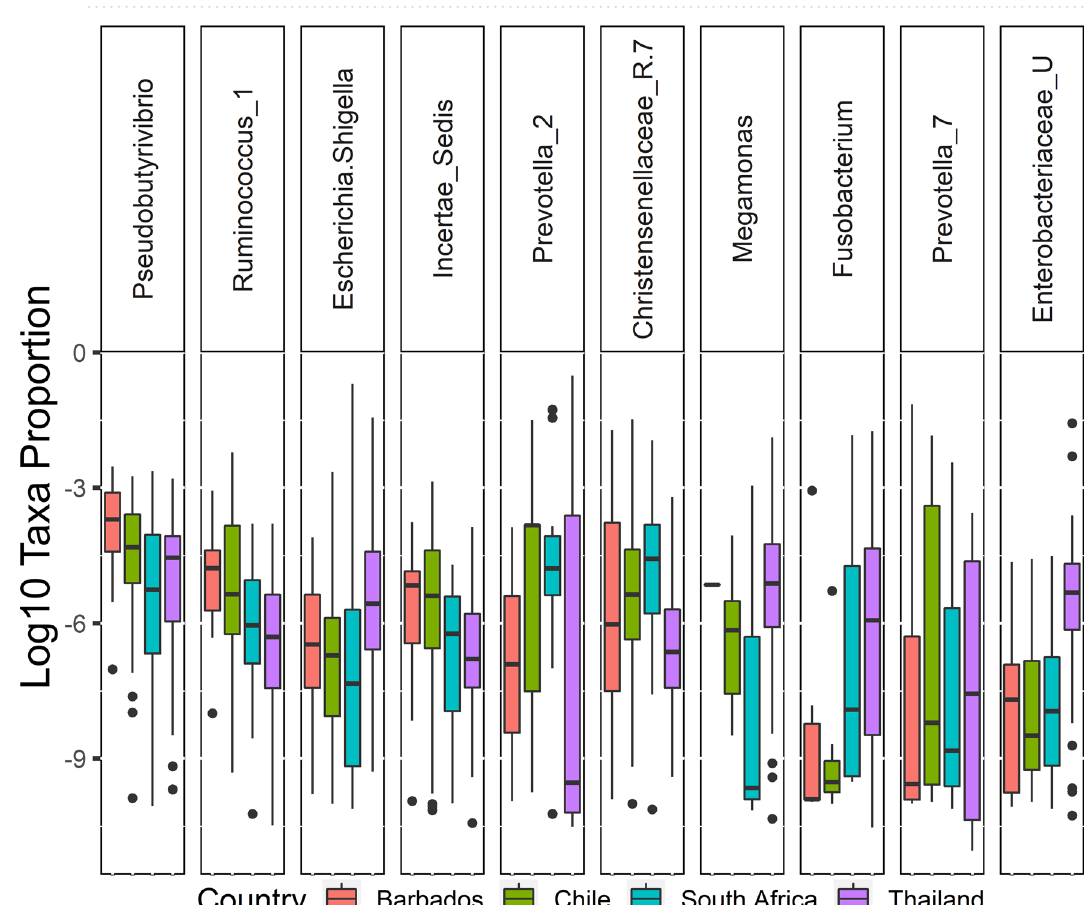
Figure 2. The significant differential abundant stool genera between four countries displayed as Box and whisker